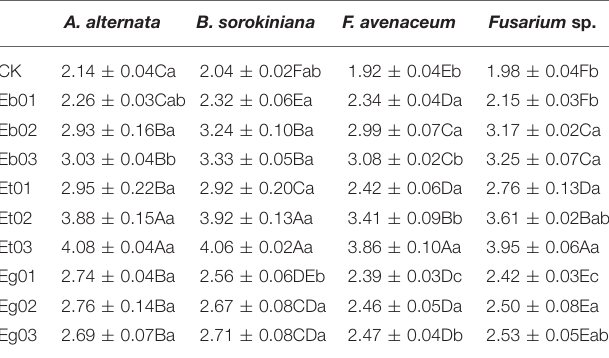
TABLE 4 | Radicle length (cm) of Elymus sibiricus under seed-borne fungi stress resulting from effects of the Epichloë